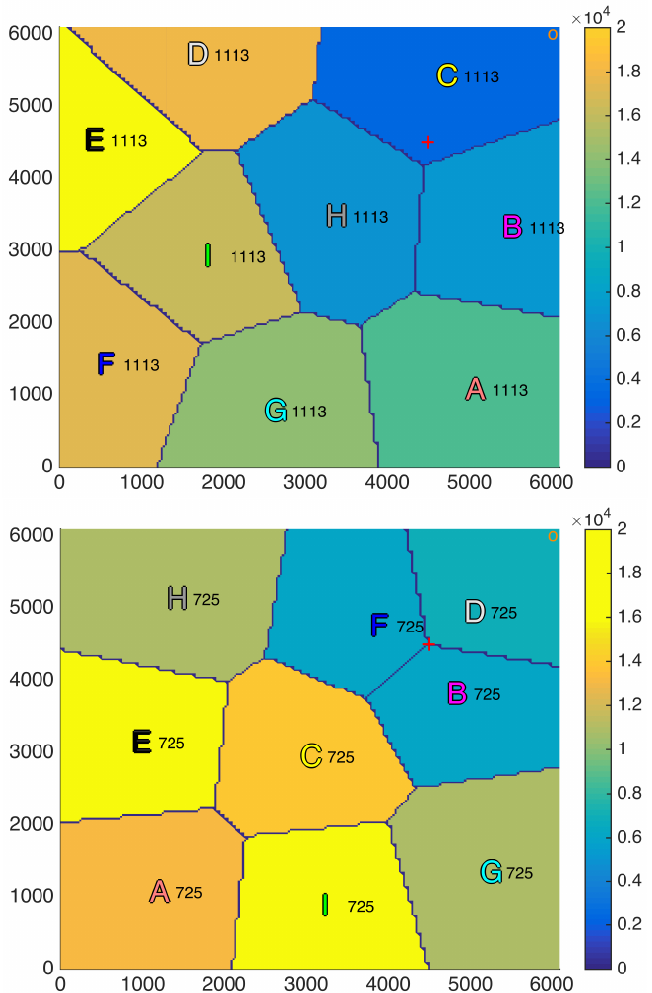
Figure 5. Position of UAVs and coverage areas using: Spiral Algorithm [12] ( top ); and k -Means Algorithm [16] ( bottom